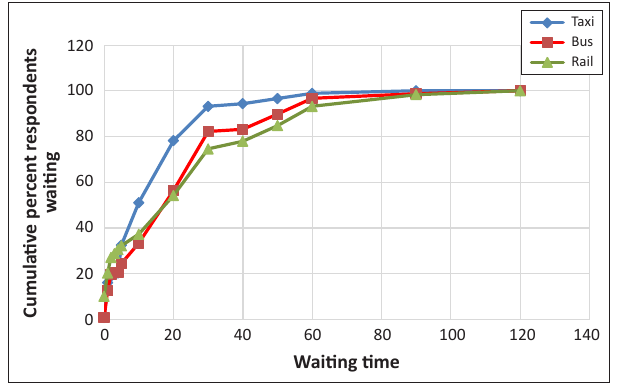
FIGURE 5: Means of transport used to access campuses.